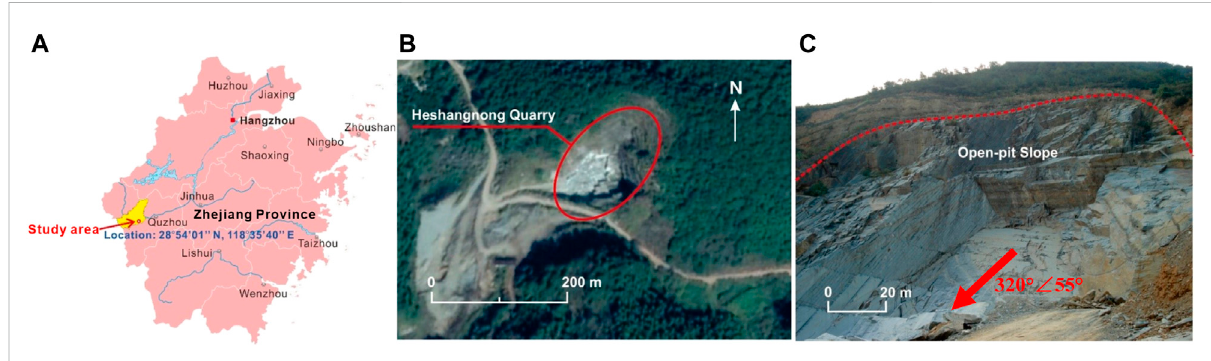
FIGURE 1 Sitesselectedfortheinvestigation. (A) Locationmapofthestudysite; (B) SatelliteviewoftheHeshangnongQuarry; (C) Viewofthestructurally- controlled open-pit slope (Du et al.,